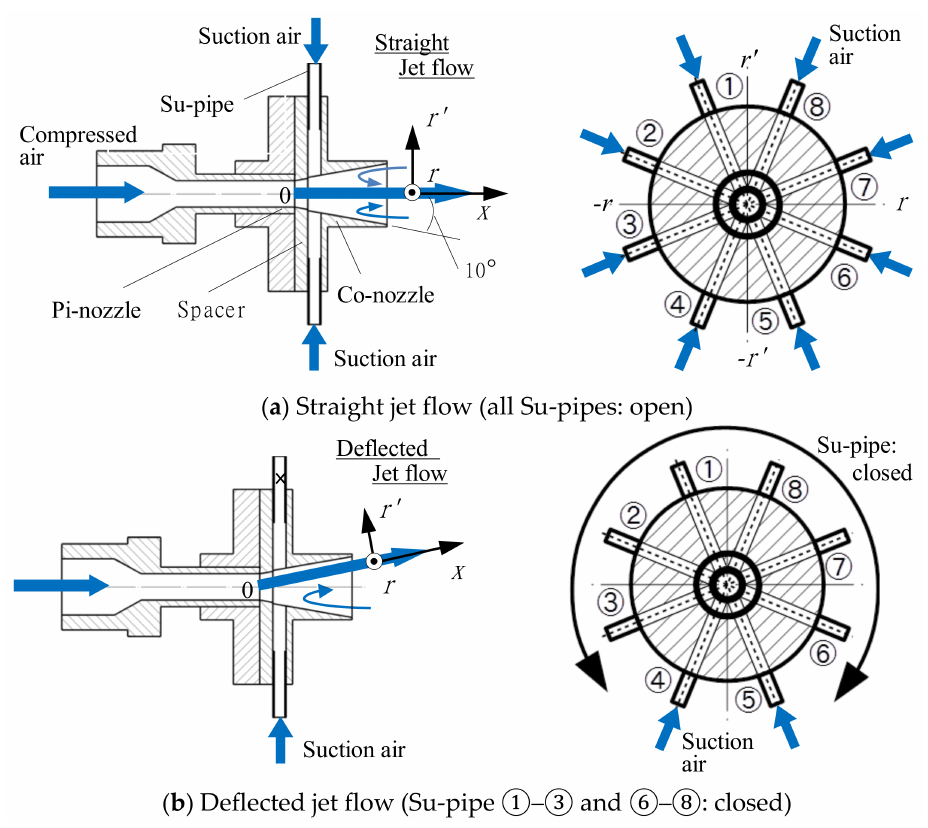
Figure 1. FC-nozzle (Fluidic thrust vector control of the Pi-jet by the FC-nozzle with 8 SU-pipes): When all Su-pipes are opened, the jet flows downstream along the nozzle axis, as shown in ( a ). When some Su-pipes are closed, the pressure between the outer edge of the jet and the wall of the Co-nozzle decreases and then the jet deflects to the closed side of Su-pipe by the Coanda effect as shown in ( b